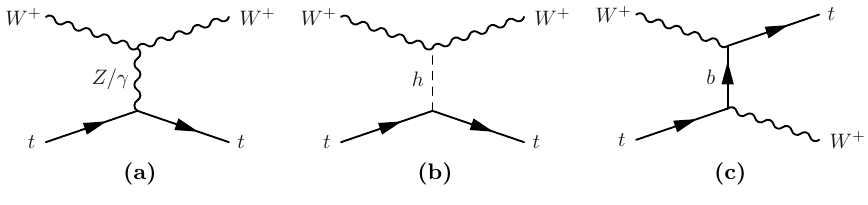
Figure 17. SM diagrams for the tW